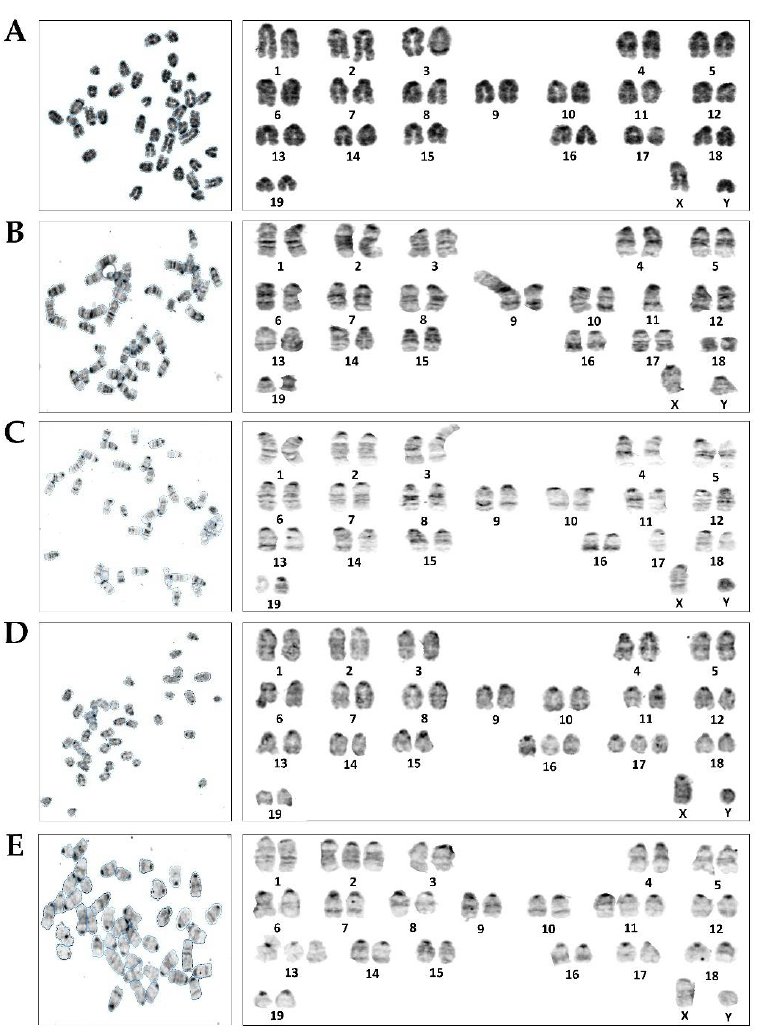
Figure 2. The spread and the karyotyped metaphase chromosomes of the negative control ( A ), the positive control, which is Etoposide-induced-Rb ( B ), 1,4-BQ-induced-Rb ( C ), 1,4-BQ-induced-hyperploidy ( D ), and the 1,4-BQ-induced-complex ( E ).